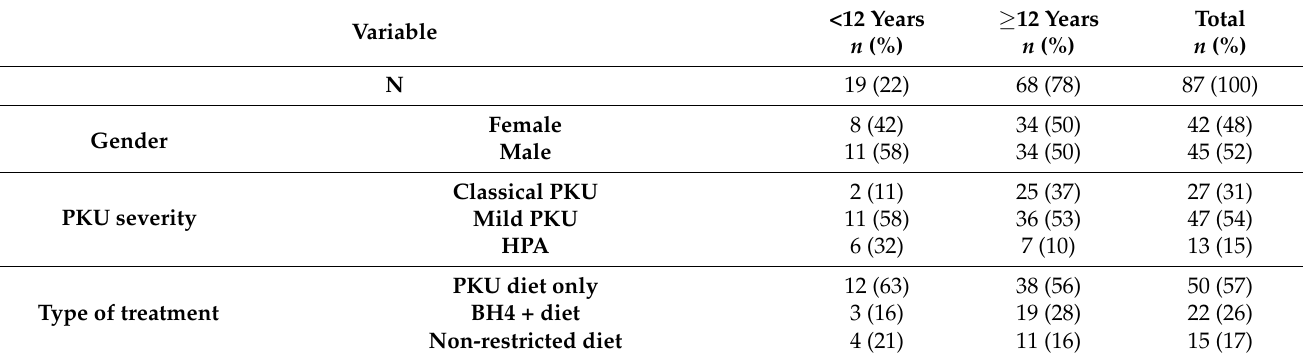
Table 1. Patient’s characteristics by type of treatment, gender, age and severity of